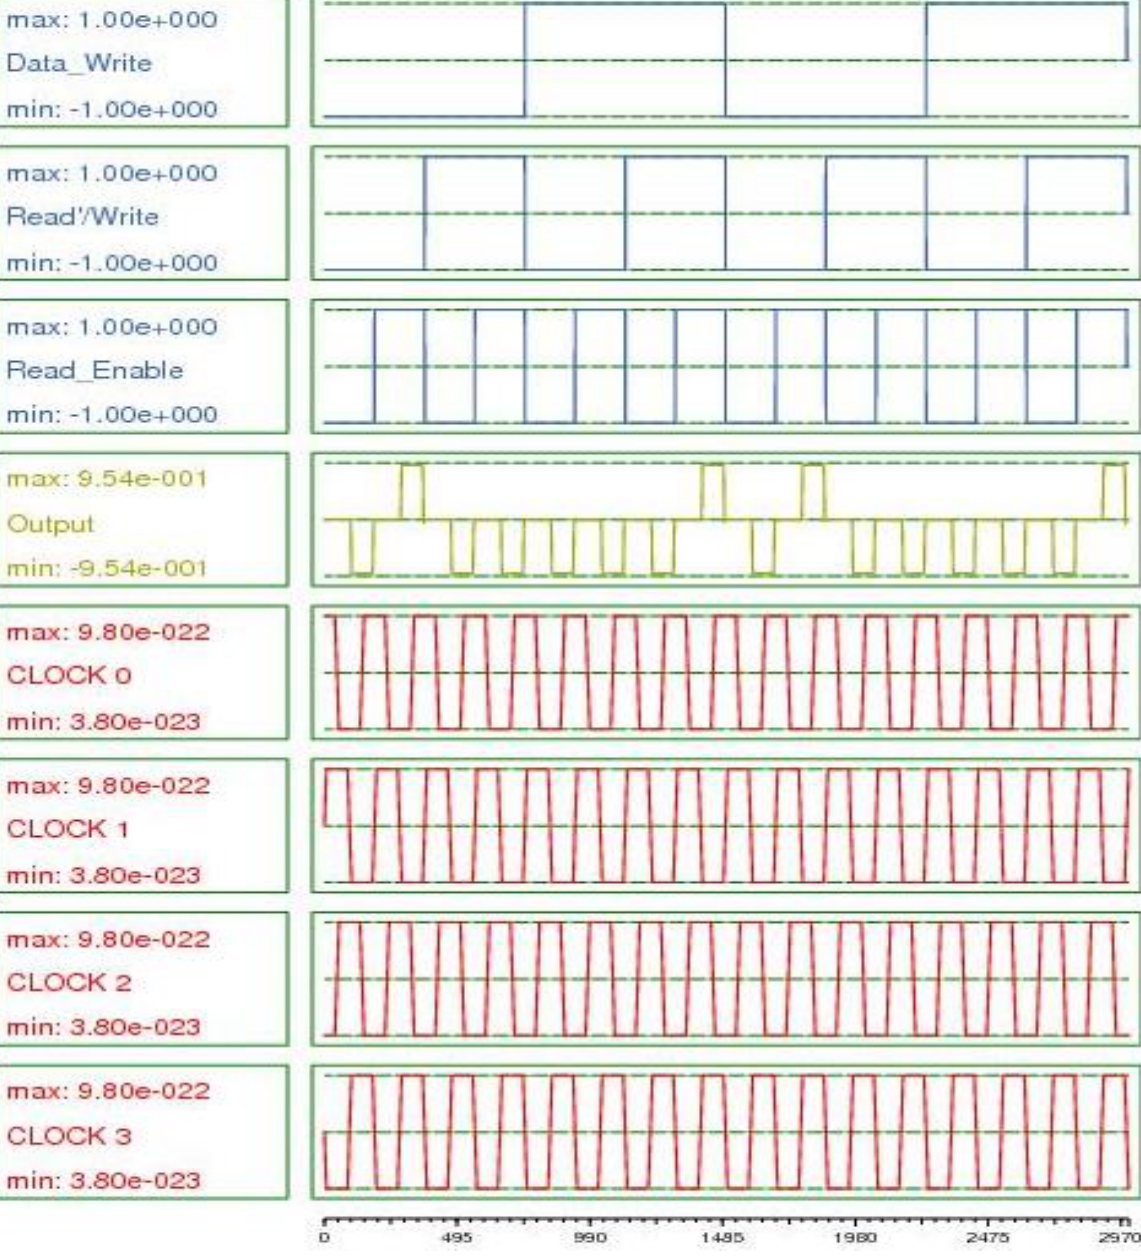
Figure 5. Simulation result of the memory cell in QCA.